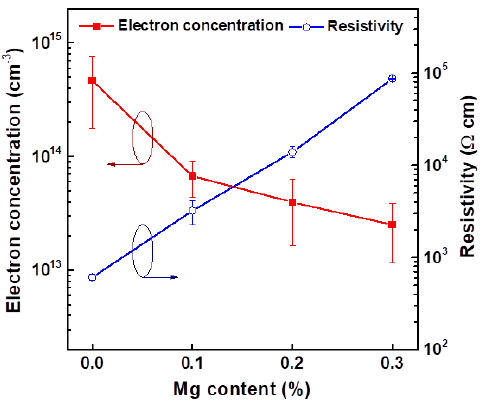
Figure 7. Variation in mean electron concentration ( n ) and mean resistivity ( ρ ) of nanocrystalline Mg x Zn 1 − x O thin films with Mg content. Mg x Zn 1 − x O thin films with Mg